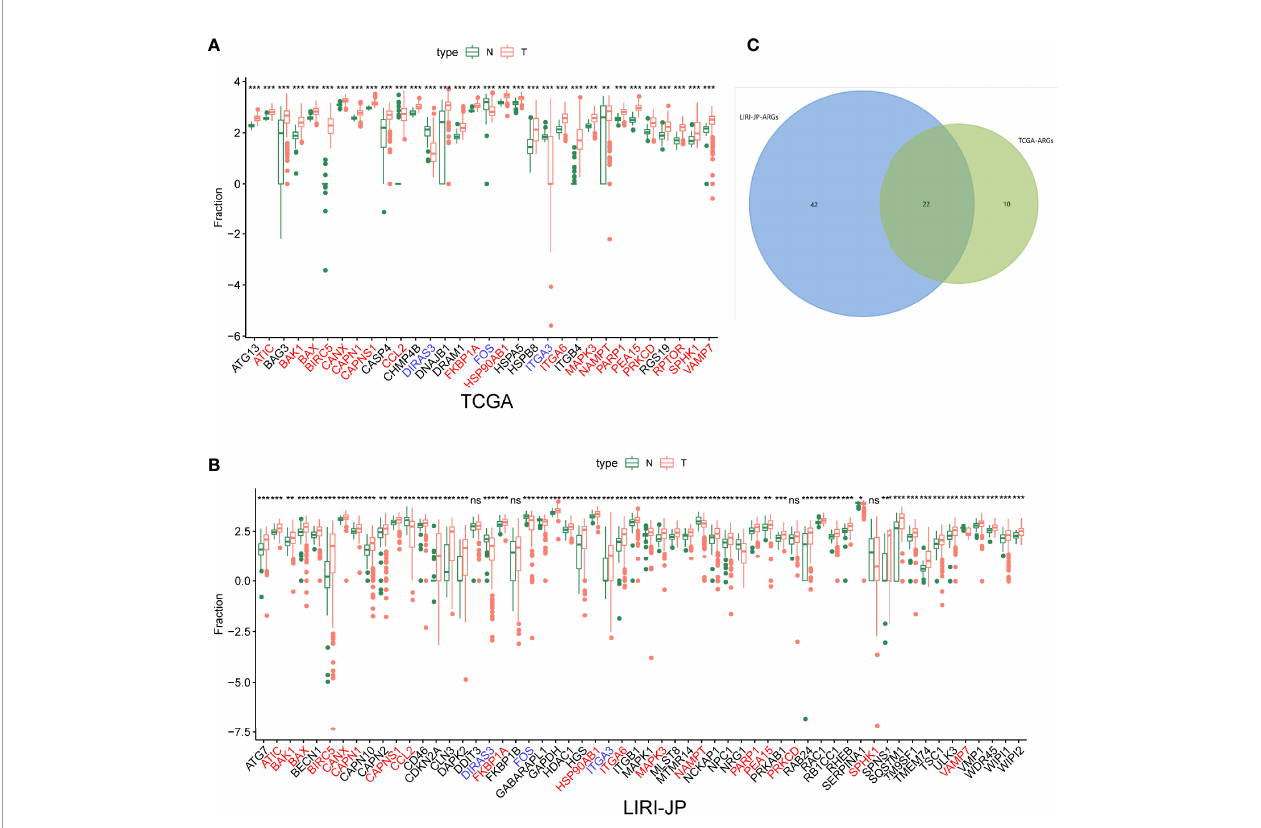
FIGURE 2 | The expression patterns of differentially expressed autophagy-related genes (ARGs) in liver cancer and normal liver tissues from two databases. (A) The expression patterns in TCGA dataset. (B) The expression patterns in the ICGC dataset. (C) Venn diagrams of the overlapping differentially expressed ARGs between TCGA and ICGC databases, including 3 signi fi cantly upregulated genes and 19 signi fi cantly downregulated genes. Ns, not signi fi cant, *p < 0.05, **p < 0.01, ***p <